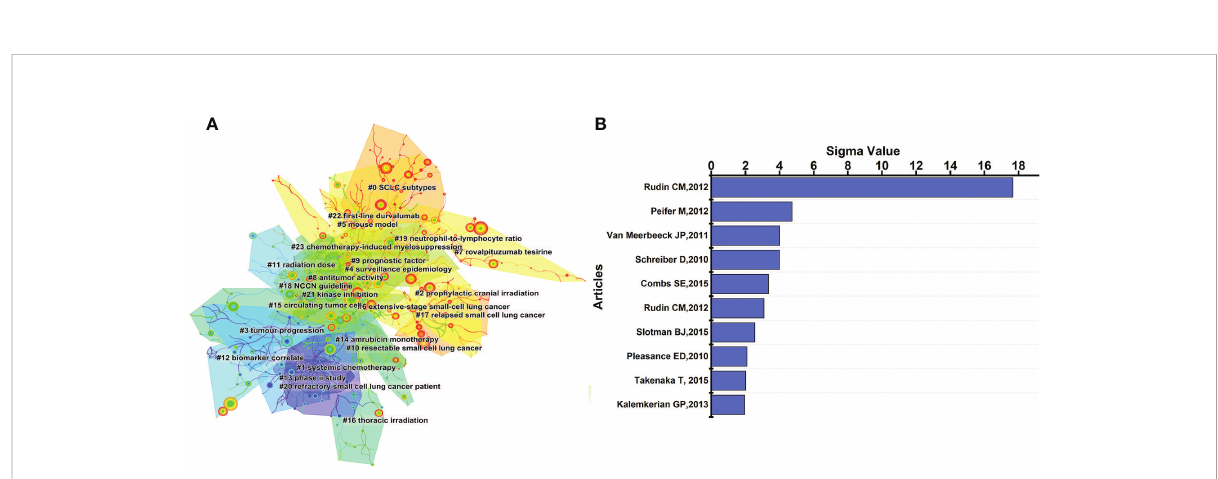
FIGURE 8 (A) Co-citation relationships between references. The fi gure shows 24 color blocks representing 24 clusters, each composed of articles on the same topic. (B) The top 10 articles of Sigma value in the reference co-citation map. Rudin CM, NAT GENET, 2012 has a much higher sigma value than other articles, proving that it is greatly innovative and